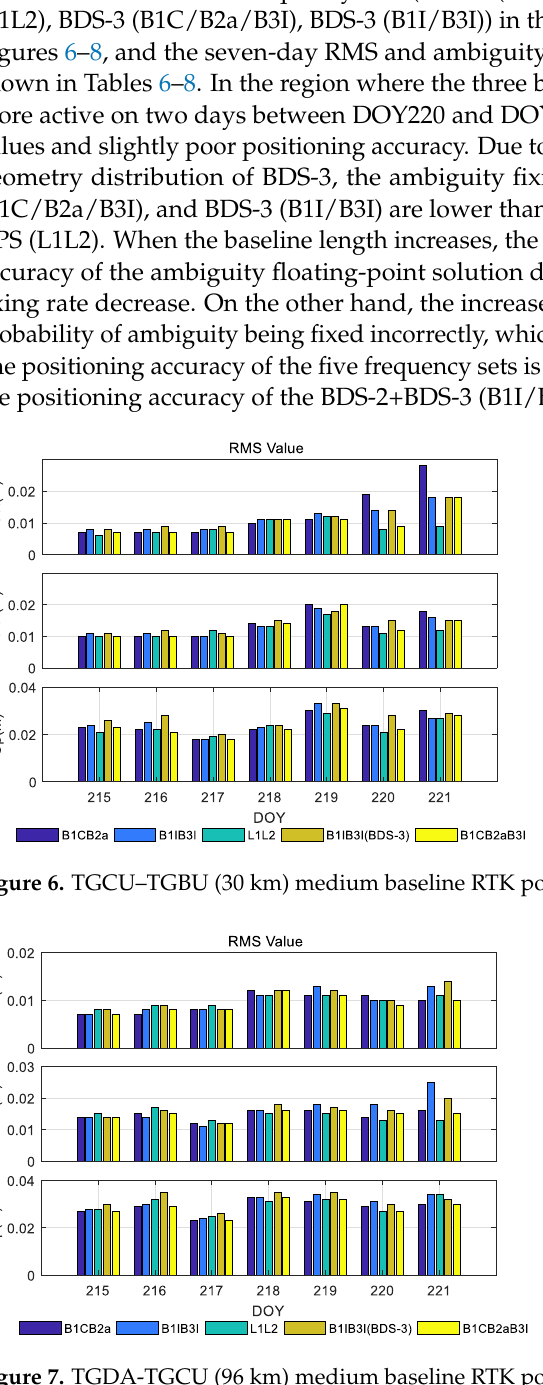
Figure 7. TGDA-TGCU (96 km) medium baseline RTK positioning accuracy. Table 7. TGDA-TGCU (96 km) average of medium baseline RTK RMS and ambiguity fixing rate.